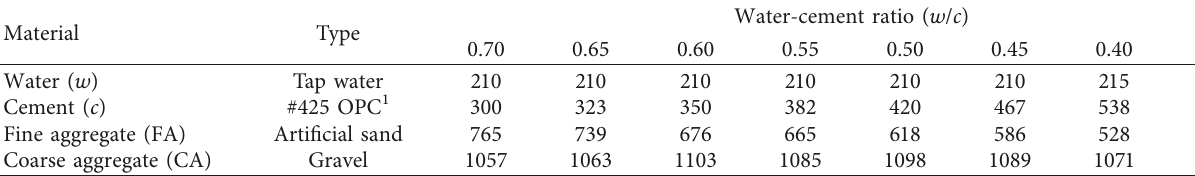
Table 3: Concrete mix proportions design (kg · m − 3 ).